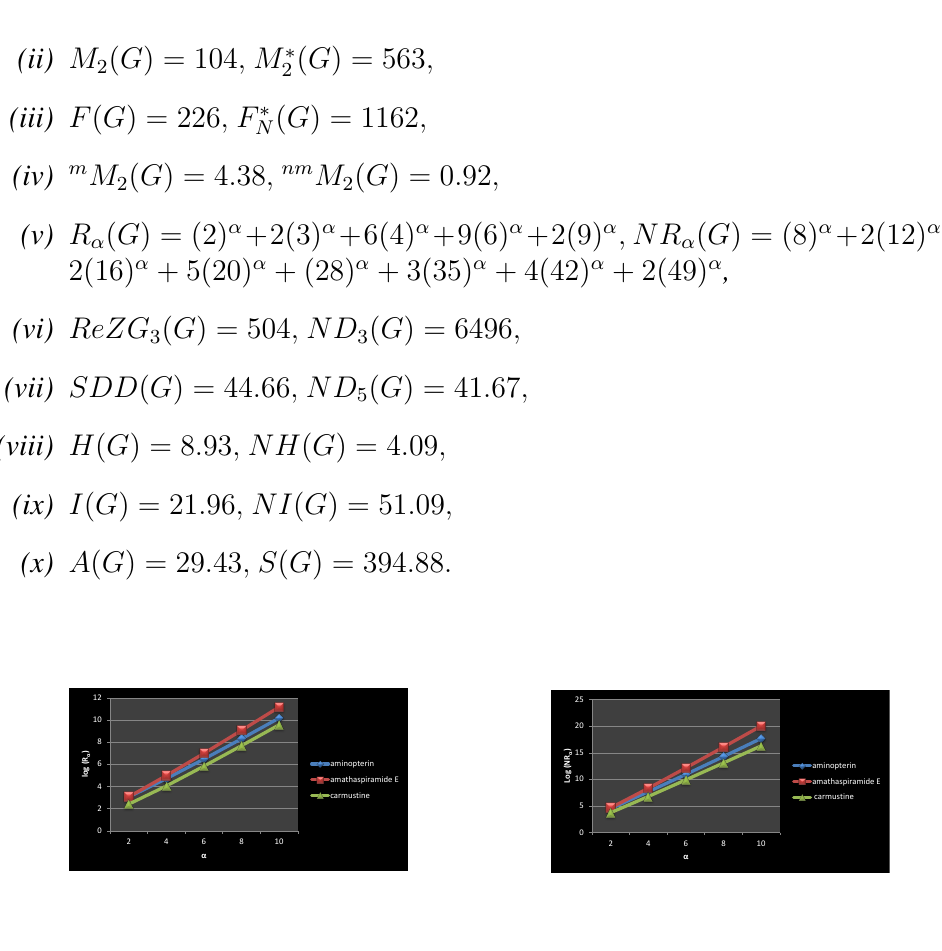
for aminopterin, amathaspiramide E and car-